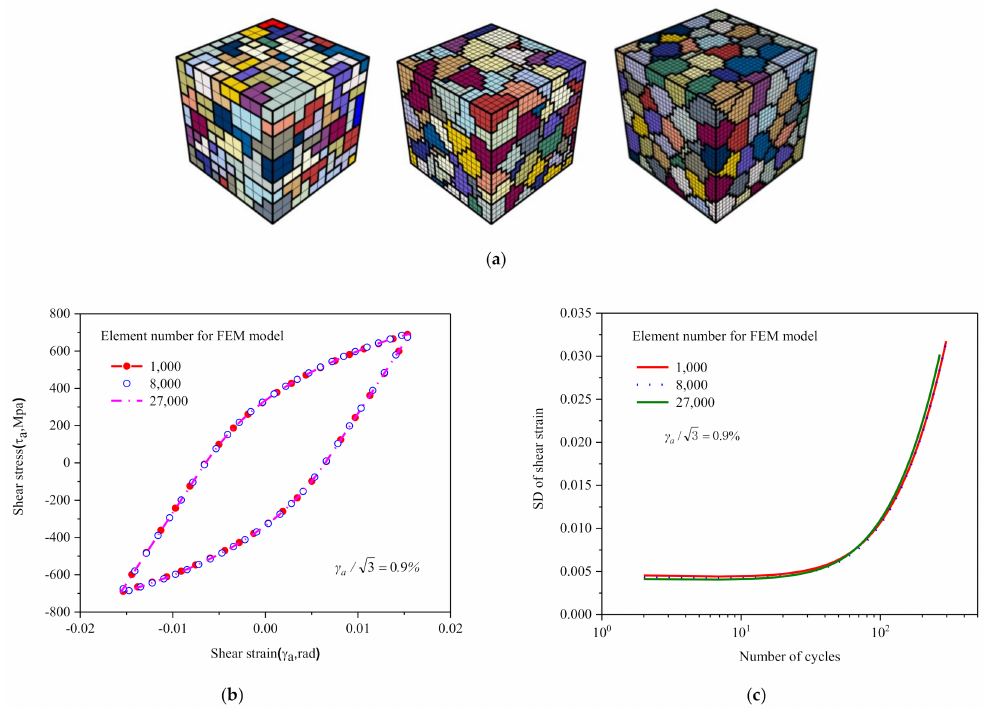
Figure 9. ( a ) The RVE model with the same number of 216 grains, containing 1000, 8000 and 27,000 elements respectively; ( b ) comparison of hysteretic curves calculated by different models; ( c ) comparison of shear standard deviations calculated by different